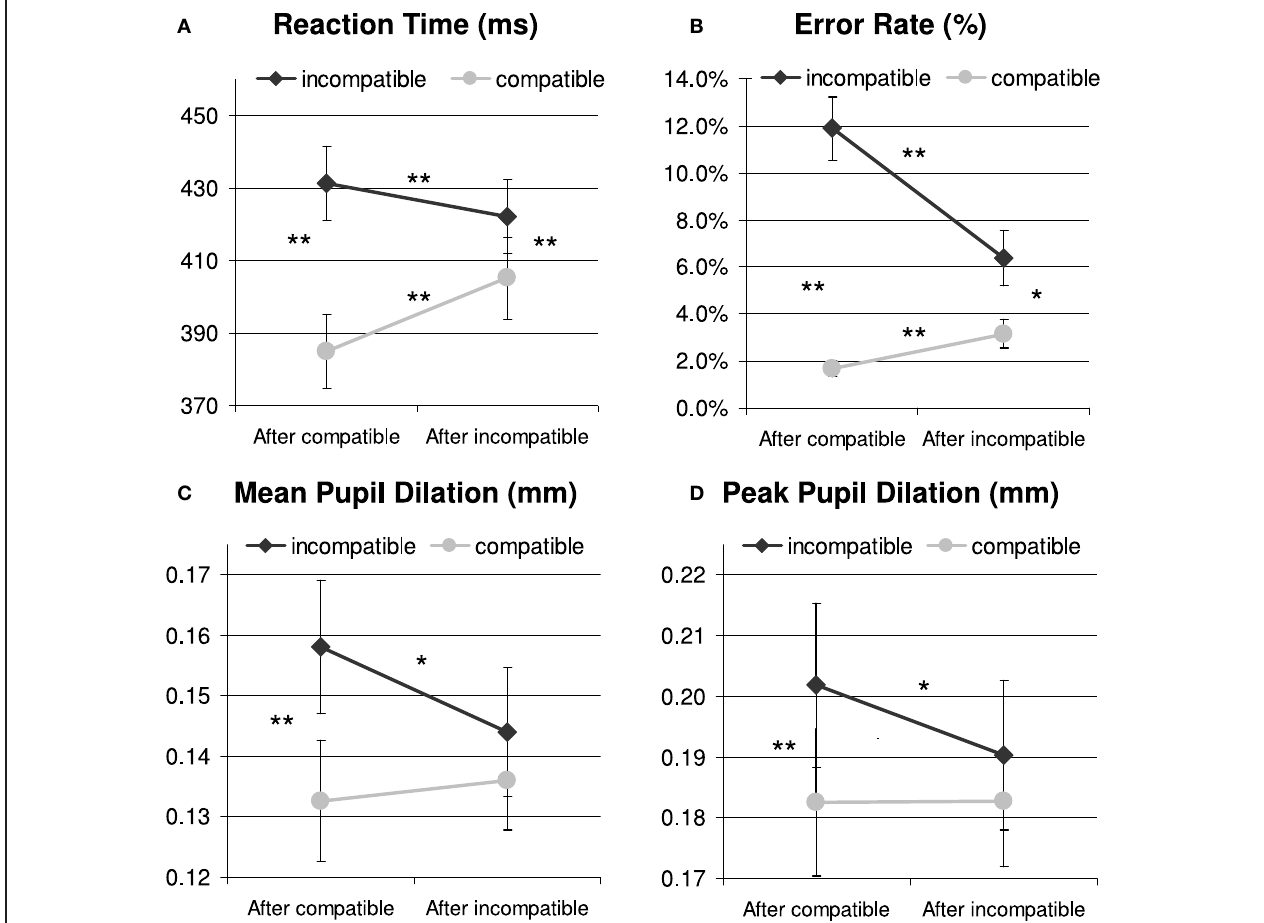
FIGURE 2 | Behavioral (A and B) and pupil dilation data relative to a 200ms prestimulus baseline (C and D) as a function of current and previous compatibility. ∗ p < . 05; ∗∗ p < 0 .